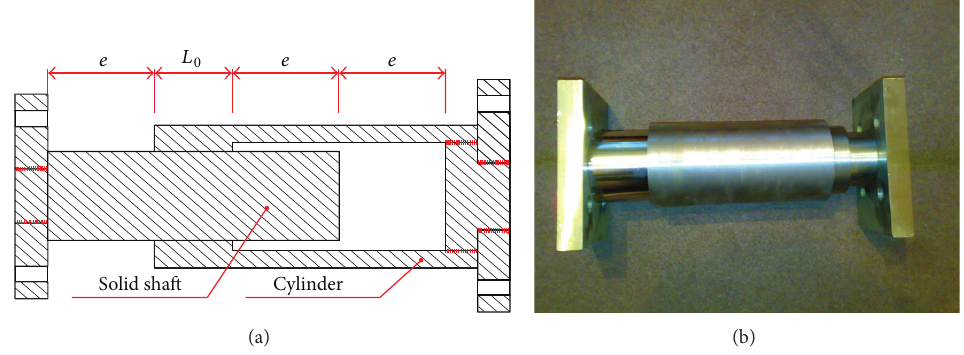
Figure 1: The CFD: (a) longitudinal section of CFD; (b) assembled CDF.